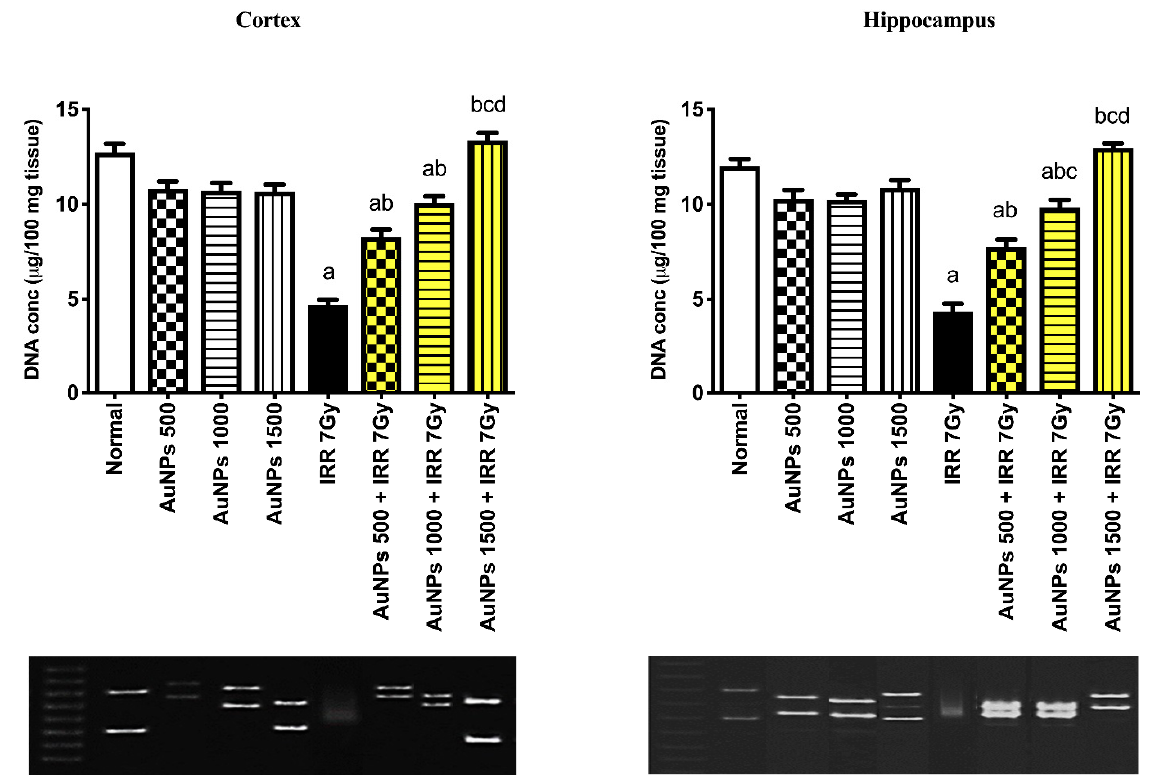
Figure 8. Effect of single oral administration of different doses of AuNPs on DNA in cortical and hippocampal tissues of 7Gy-irradiated rats. Every bar with a vertical line displays the mean ± S.E ( n = 6). a vs. normal, b vs. IRR 7Gy, c vs. AuNPs 500 + IRR 7Gy, d vs. AuNPs 1000 + IRR 7G; p < 0.05.